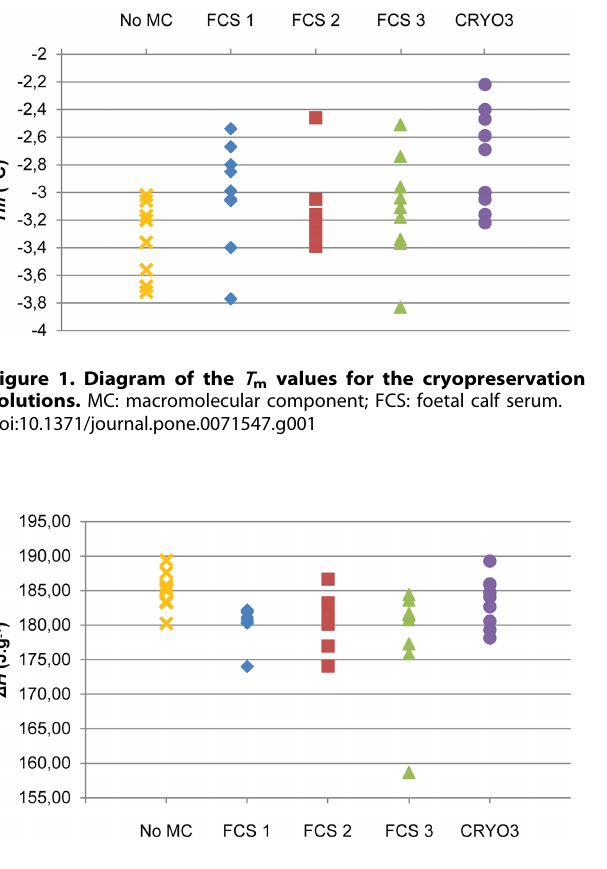
Figure 2. Diagram of the D H values for the cryopreservation solutions. MC: macromolecular component; FCS: foetal calf